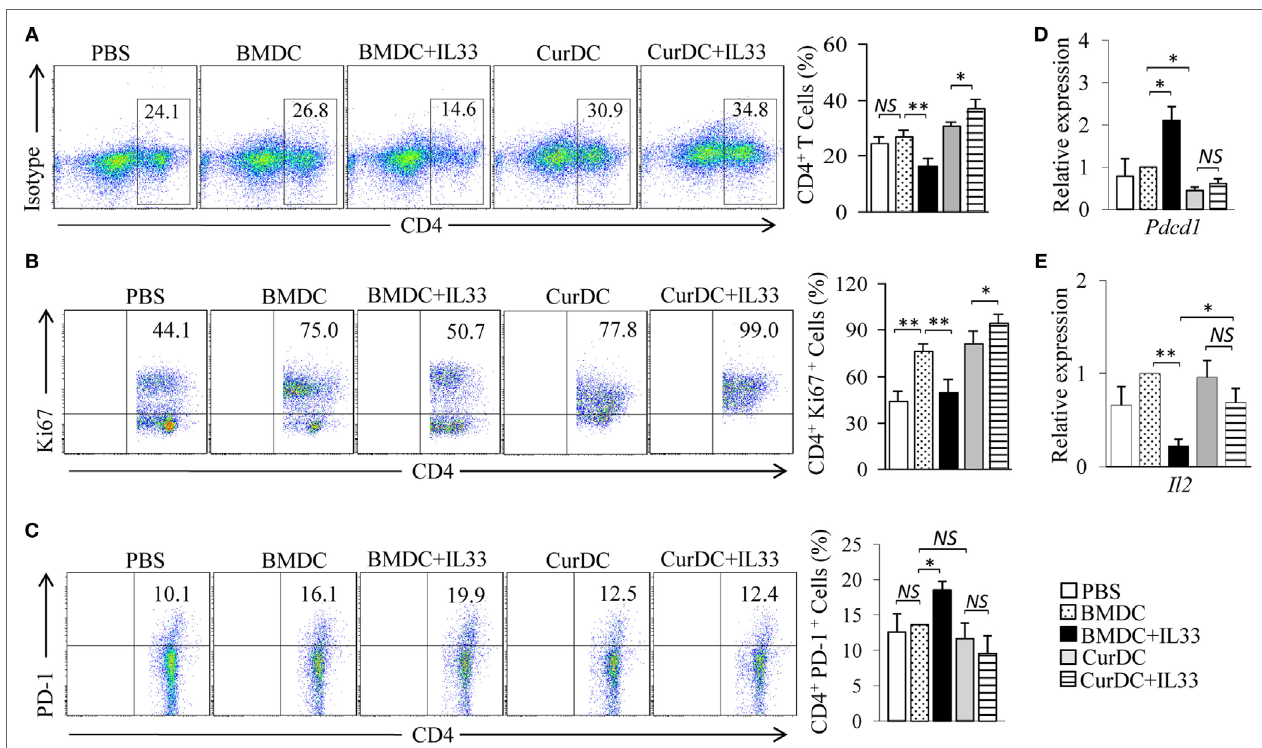
FigUre 6 | Interleukin (IL)-33 maintains the cell proliferation capability of dectin-1-activated dendritic cell (DC)-primed T helper cells in vivo . OT-II mice (two to three mice/group) were immunized twice (1 week apart) with OVA-peptide-pulsed BMDCs or CurDCs. In addition, some of the mice immunized with BMDCs or CurDCs were given IL-33 (250 ng/mouse) every 3 days, beginning on the day of the first immunization. Mice received PBS served as controls. Mouse spleen cells were restimulated with BMDCs or CurDCs in the presence or absence of IL-33 (50 ng/mL) for 2 days in the culture. (a) Flow cytometry analysis of CD4 + T cells in mouse spleen cells. Right, summarized results of three independent experiments obtained as at left. The experiments were performed three times ( n = 3). (B) Flow cytometry analysis of Ki67 + CD4 + T cells. Right, summarized results of three independent experiments obtained as at left. The experiments were performed three times ( n = 3). (c) Flow cytometry analysis of PD-1 + CD4 + T cells. Right, summarized results of three independent experiments obtained as at left. The experiments were performed three times ( n = 3). (D,e) CD4 + T cells were isolated by the magnetic cell sorting. Quantitative polymerase chain reaction examined the expression of Pdcd1 (D) and Il2 (e) in CD4 + T cells. The experiments were performed three times ( n = 3). Data are presented as mean ± SD of three (D,e) independent experiments. NS , non-significant; * P < 0.05; ** P < 0.01 .